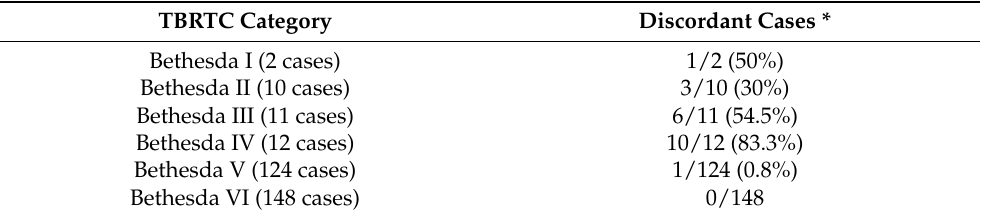
Table 5. Cytologic/histological evaluation of the discrepancies between cytology and histopathology in subcentimeter lesions.